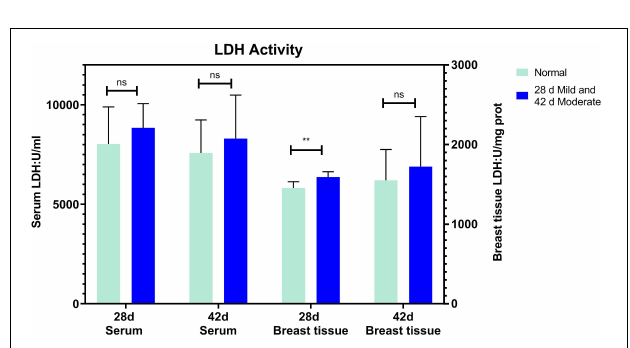
FIGURE 3 | Creatine kinase (CK) activity in serum and breast tissue at 28 ( n = 20 in total) and 42 days of age ( n = 49 in total). *** P < 0.001; * P < 0.05; ns, P > 0.05.